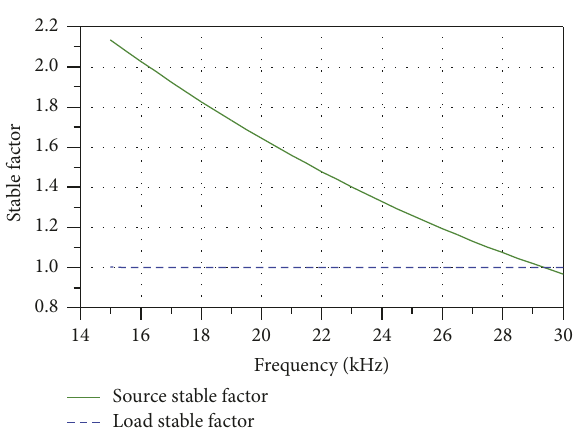
Figure 7: Stable factor of source and load port of the non-Foster matching